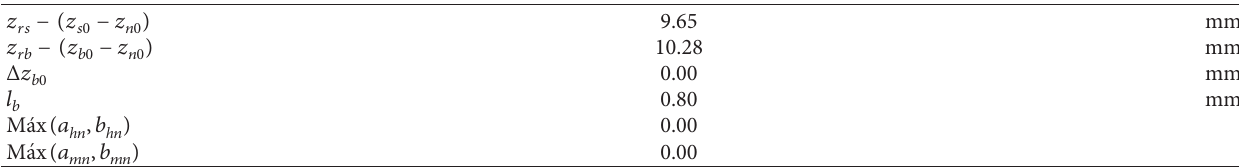
Table 5: Calculated parameters, Case II.